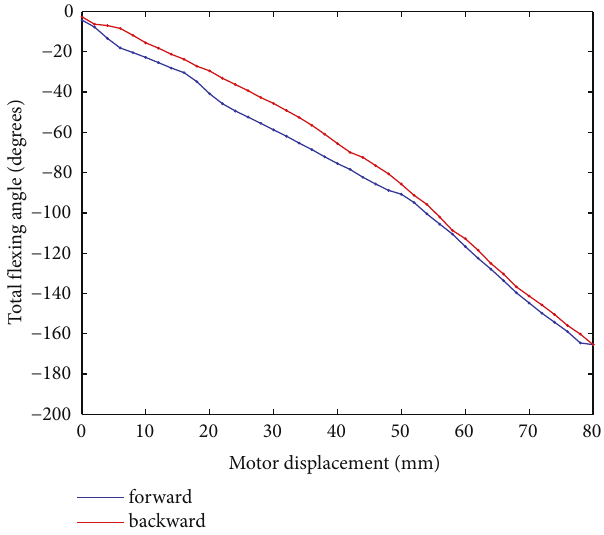
θ 1 and 5 of all volunteers.